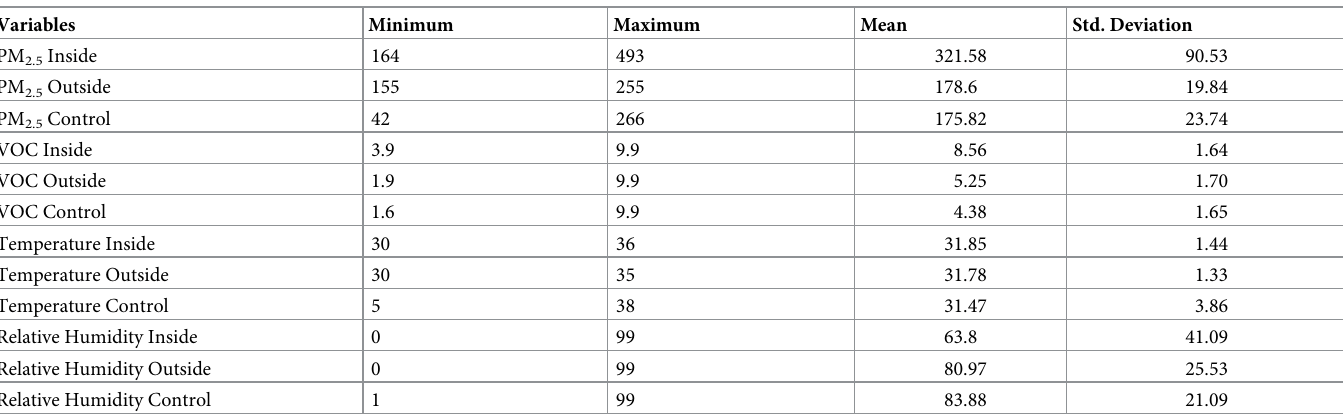
Table 3. Descriptive statistics of